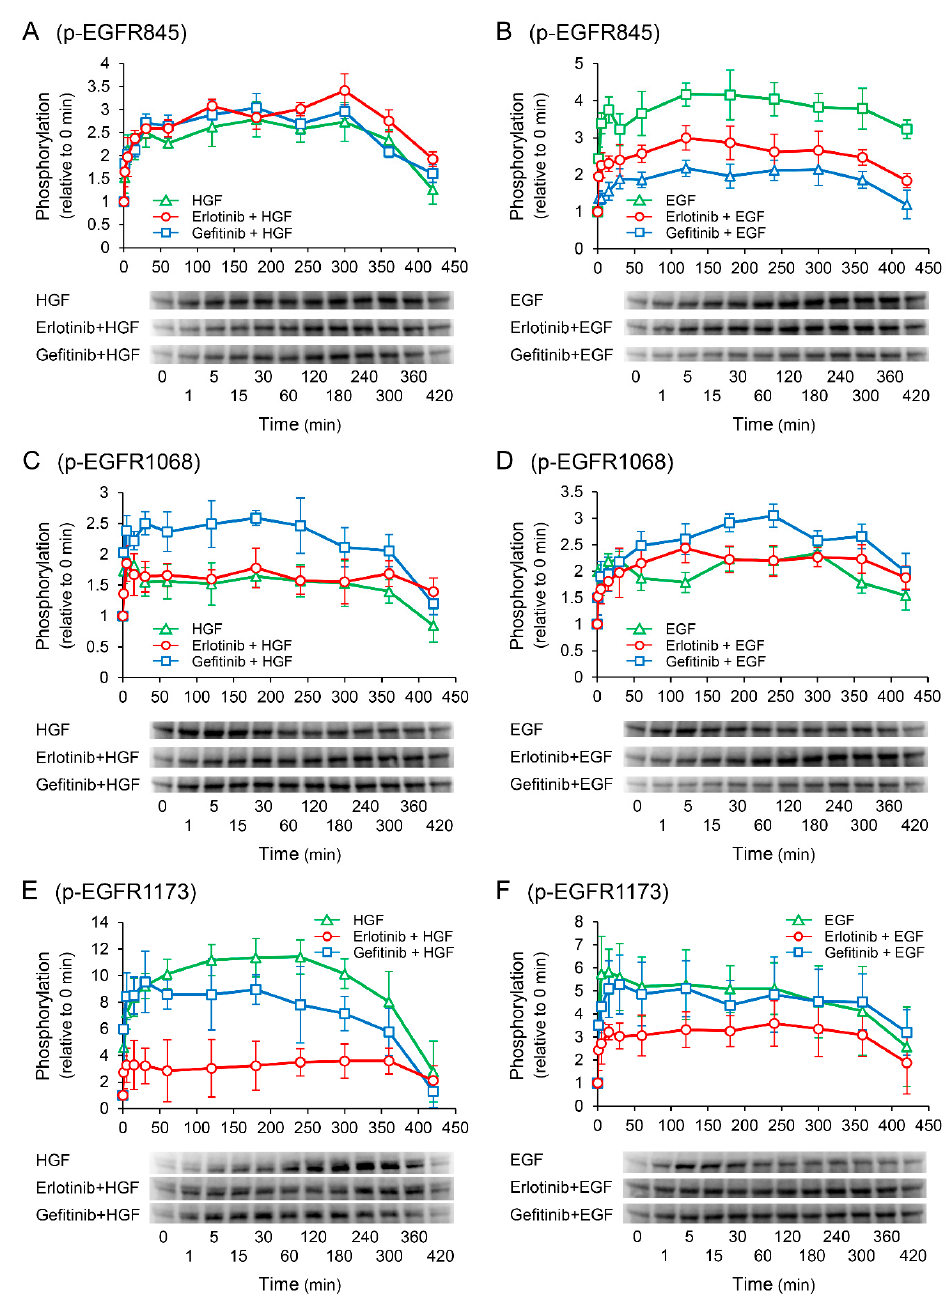
Figure 7. Effects of erlotinib and gefitinib on growth factor-induced phosphorylation of epidermal growth factor receptor (EGFR). HepG2 cells were cultured for 24 h in serum-starved medium. Thereafter, HGF (50 ng/mL) or EGF (50 ng/mL) was added to the medium. Cells were pretreated with erlotinib (5 µM) or gefitinib (1 µM) 15 min before treatment with growth factors. Total protein was collected at the indicated times points. The relative amount of phosphorylated protein in each band was quantified by ImageQuant TL software, and phosphorylation trends at Tyr845 ( A , B ), Tyr1068 ( C , D ), and Tyr1173 ( E , F ) after treatment with growth factors were plotted on graphs. The intensity of phosphorylation is expressed relative to that at 0 min. Western blot analysis was performed in 3 experiments for 3 different preparations, and representative blots are shown. Each bar represents the mean ±